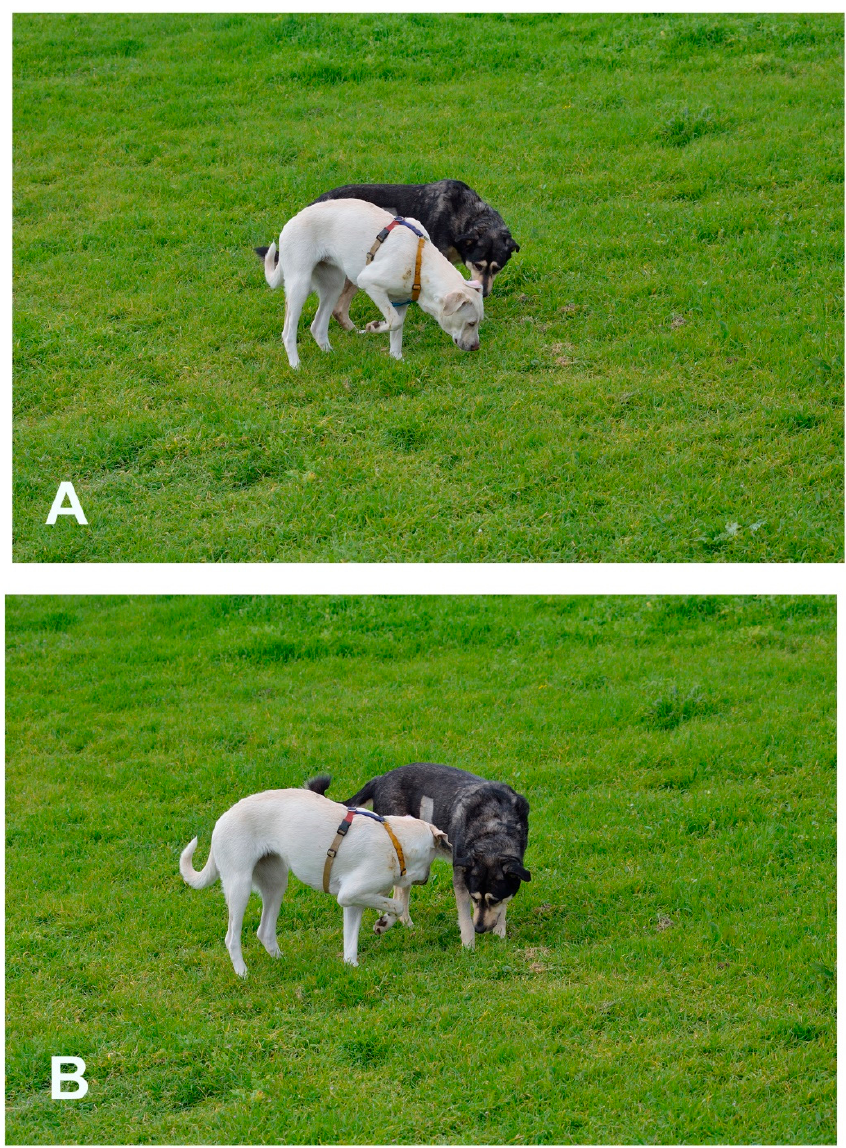
Figure 7. The white female is sniffing urine marking; the black female (with a shaved area on her right side due to an ecographic analysis) uses the urine marking as a resource to make clear a conflict with the white female. ( A ) In the first photo, the black female is asking distance and the eye contact is very clearly showing a threat. ( B ) In the second photo, the white female turns and goes away from the urine marking and the body language of the black female become more possessive; the direction of the head is on the urine marking, the direction of the eyes is on the white female (pictures taken from a video footage).